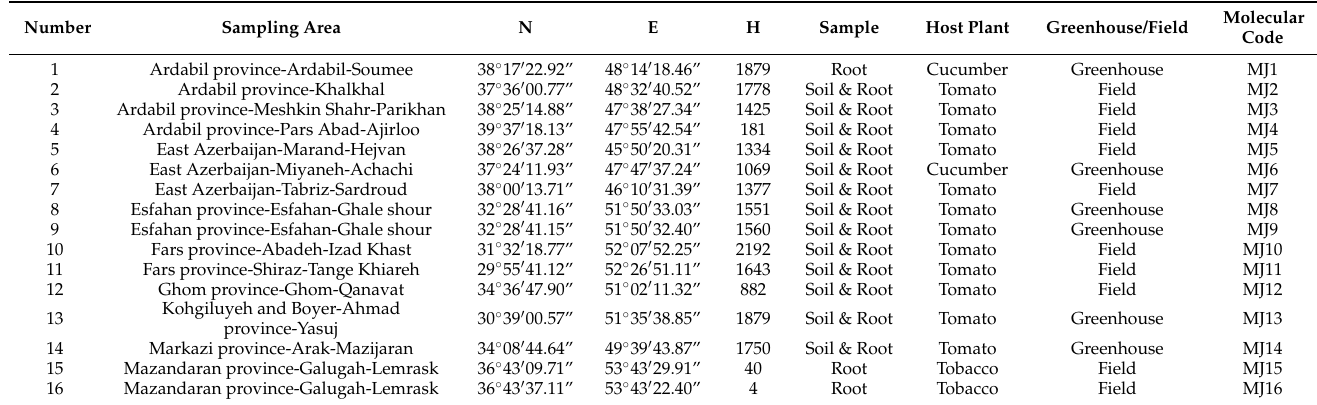
Table 1. Meloidogyne javanica populations collected from different regions of